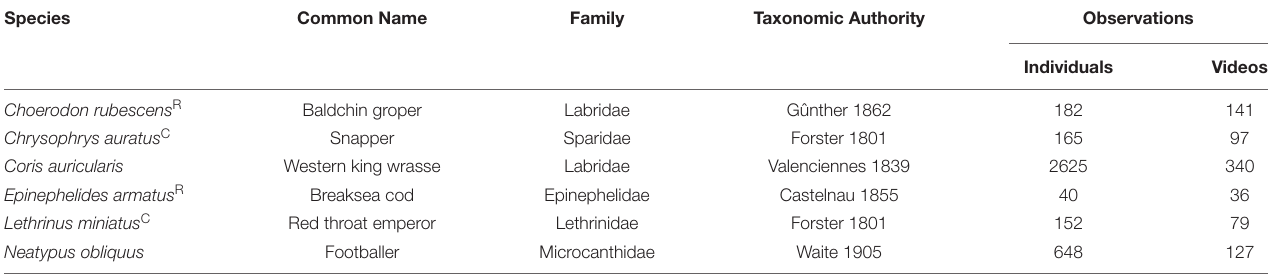
TABLE 1 | Summary of the focus species for this study.